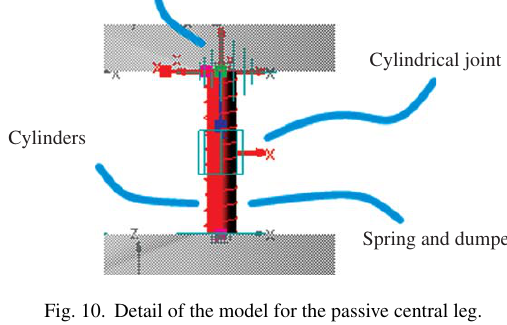
Fig. 10. Detail of the model for the passive central